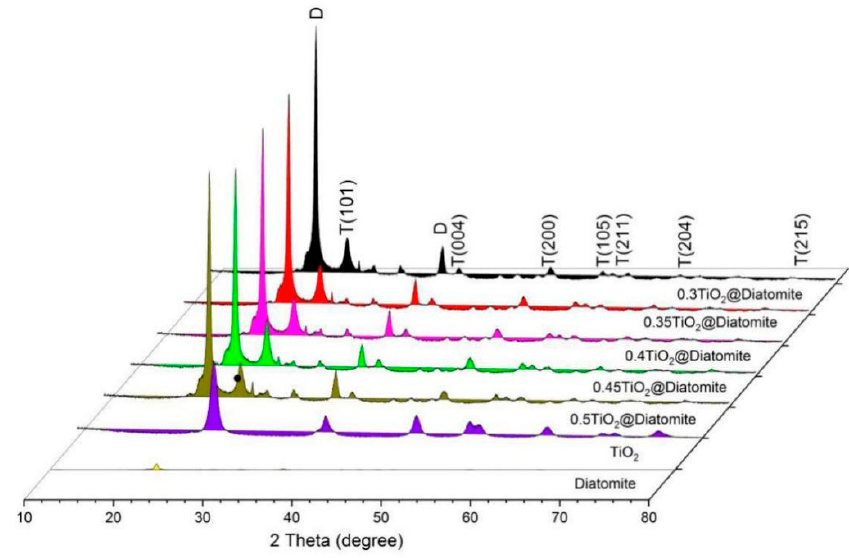
Figure 1. XRD patterns of TiO 2 , diatomite, and XTiO 2 @diatomite.